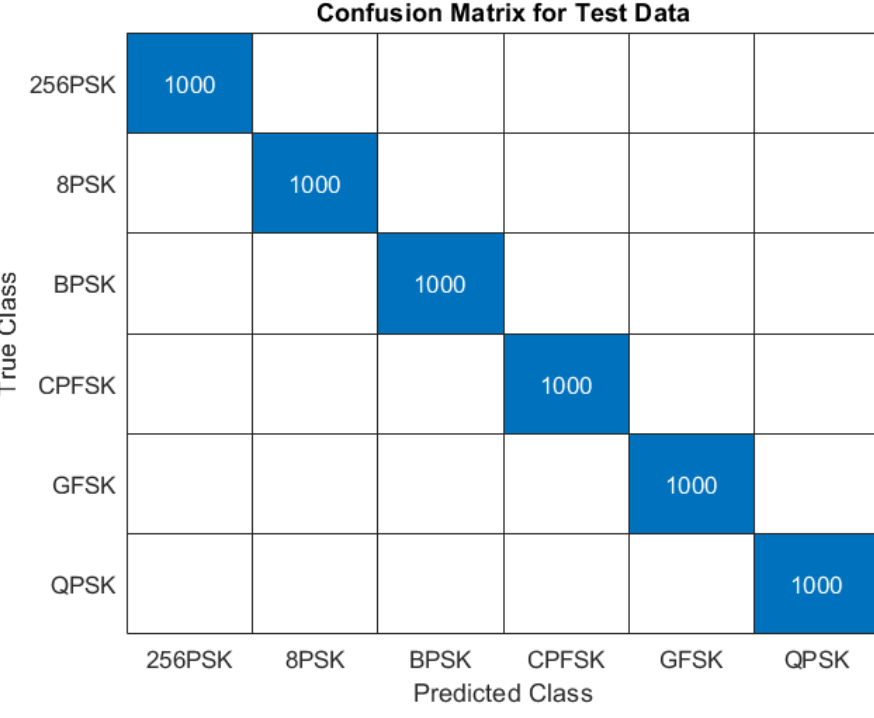
Figure 4. Confusion Matrix for Case-I at SNR = 5